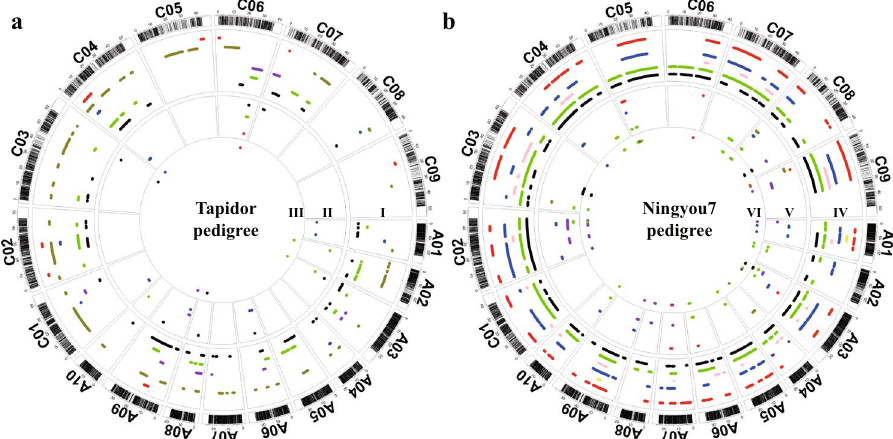
Figure 4. Distribution of QTLs detected for flowering time, seed quality and root morphology traits within the Bna TNDH population, and the candidate genes underlying the QTL region located in IBDs of cultivars of the Tapidor and Ningyou7 pedigrees. The outermost circle represents the SNP markers located on the genome of cultivar Darmor- bzh . Circle ‘I’ indicates the locations of IBD blocks on each of the chromosomes within the Tapdior pedigree; ‘IV’ within the Ningyou7 pedigree. Circle ‘II’ represents the additive effect QTLs for different agronomic traits located in the IBD regions within the Tapidor pedigree, and ‘V’ within the Ningyou7 pedigree. Circle ‘III’ demonstrates the candidate genes located in the QTL regions within the Tapidor pedigree and ‘VI’ within the Ningyou7 pedigree.